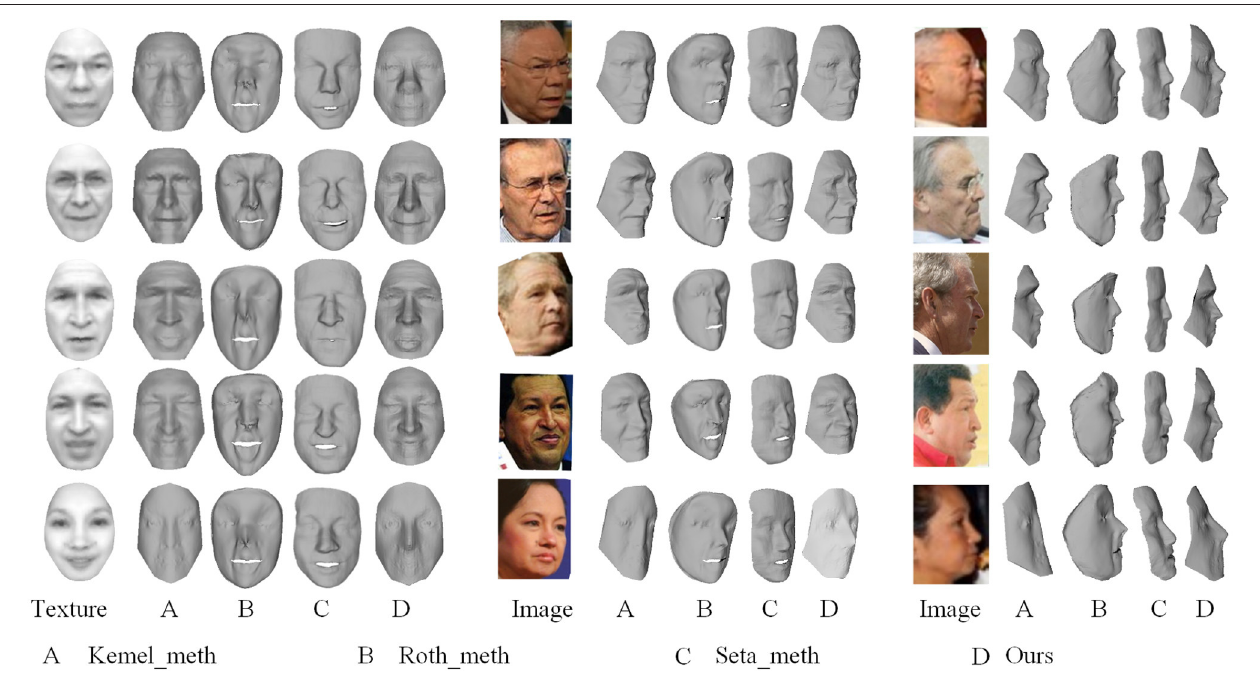
FIGURE 8 | Visual reconstructions and comparisons for Colin Powell, Donald Rumsfeld, George W. Bush, Hugo Chavez, and Gloria Macapagal Arroyo: (1) Images in column 1, 5, and 9 are corresponding mean textures and two views of images, respectively; (2) Columns labeled by A show the results generated by the reimplemented Kemel_meth, and columns labeled by B show the results generated by the reimplemented method Roth_meth, and columns labeled by C show the results generated by the Seta_meth, and columns labeled by C show our results. (The face images used in the figure come from LFW database 1